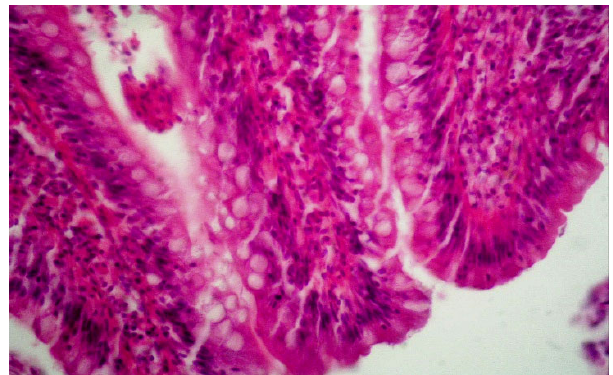
Fig. 4. Intestinal villi of carp in Experiment 3 with a significant number of goblet cells, hemocapillary dilatation. H&E. x 400